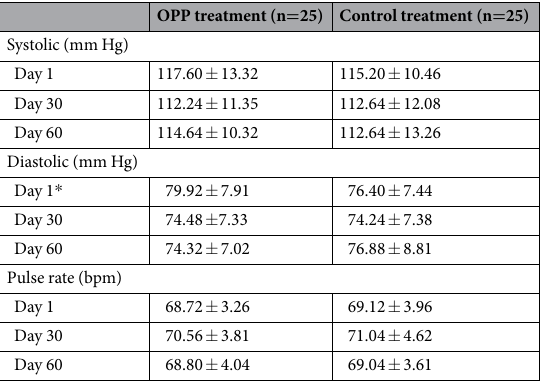
Table 4. Blood pressure profiles (mean ± SD). * Baseline diastolic level (day 1) was significantly different between treatments, p = 0.043 (Wilcoxon’s signed-rank test). Values were further used as covariate in repeated measures. The time × treatment analysis was however not significant, p = 0.118 (2-factor repeated measures